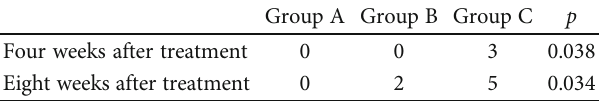
Table 4: Comparison of recurrence rate among three groups.